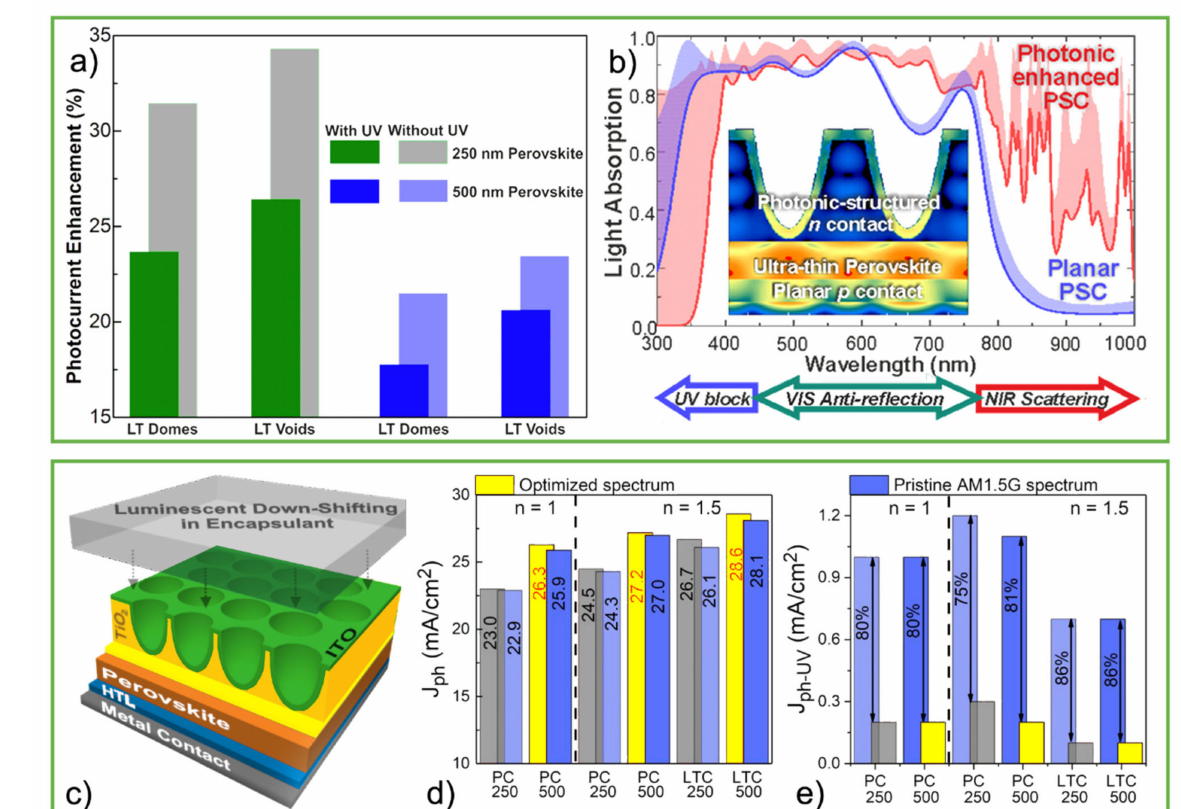
Figure 14. ( a ) Photocurrent enhancements attained with the optimized photonic structures presented in Haque’s work. ( b ) Light absorption spectra of PSCs with (photonic-enhanced) and without (planar) the optimized LT structures integrated into the ETL of the cell—a low absorption in the UV region indicates the desired blocking effect caused by the photonic structure. Adapted with permission from [27]. Copyright 2021 Elsevier. ( c ) Sketch of the luminescent down-shifting material encapsulating the photonic-structured PSC. ( d ) J ph values obtained considering the full UV-Visible-NIR wavelength range (300–1000 nm), for two different refractive indexes (n) values of the encapsulating media. ( e ) UV photocurrent (J ph-UV ) values for wavelengths ranging from 300 to 400 nm (the more transparent bars refer to the devices with 250 nm perovskite thickness, while the others refer to those with 500 nm). Adapted with permission from [28]. Copyright 2021 American Chemical